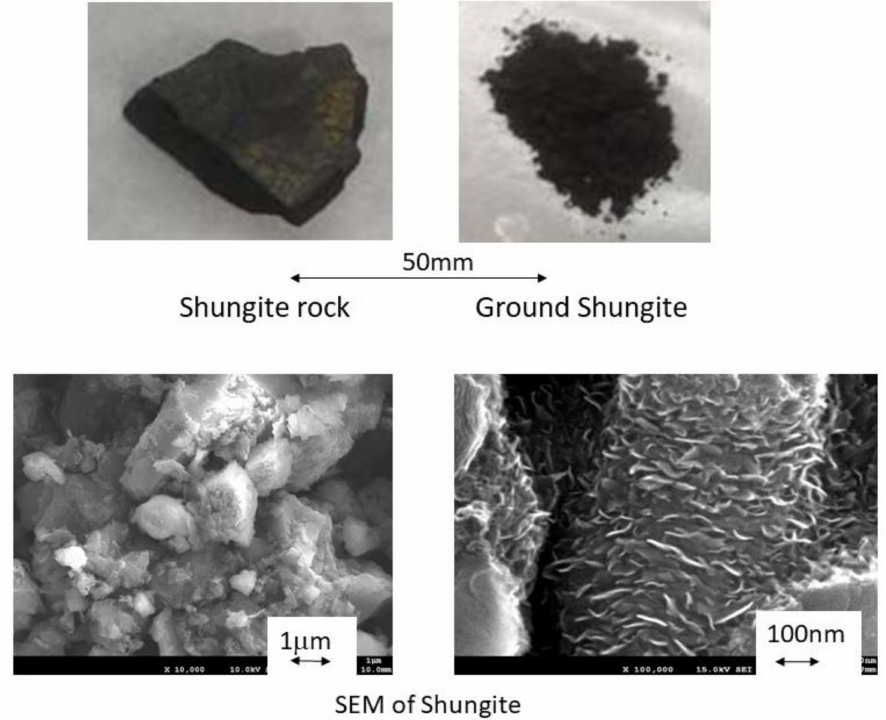
Figure 1. Photographs of the investigated shungite rock and ground powder and scanning electron microscopy